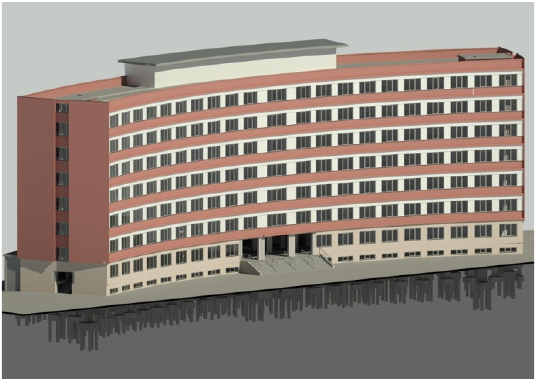
Figure 9: Frontal view of the architectural